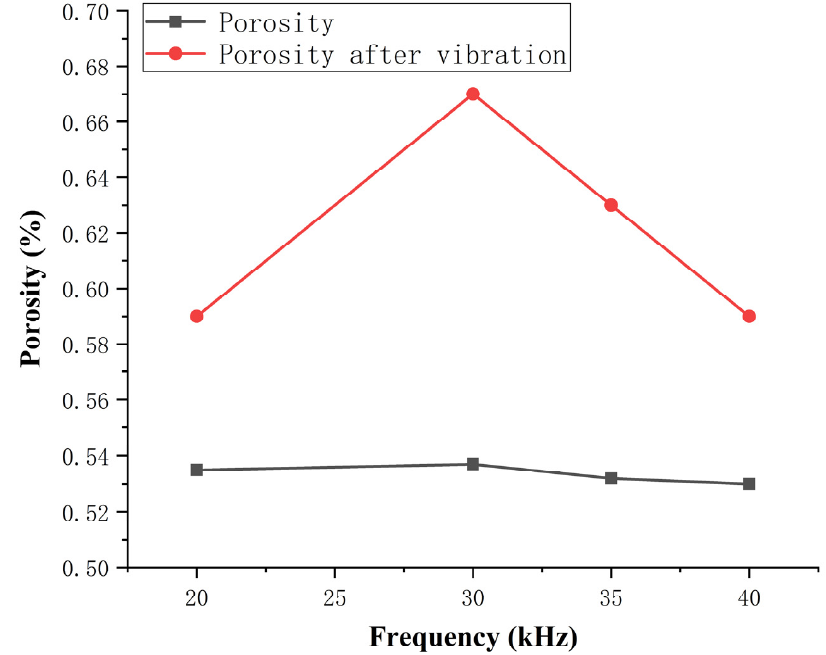
Figure 2. Variation curve of rock sample porosity caused by different frequencies.